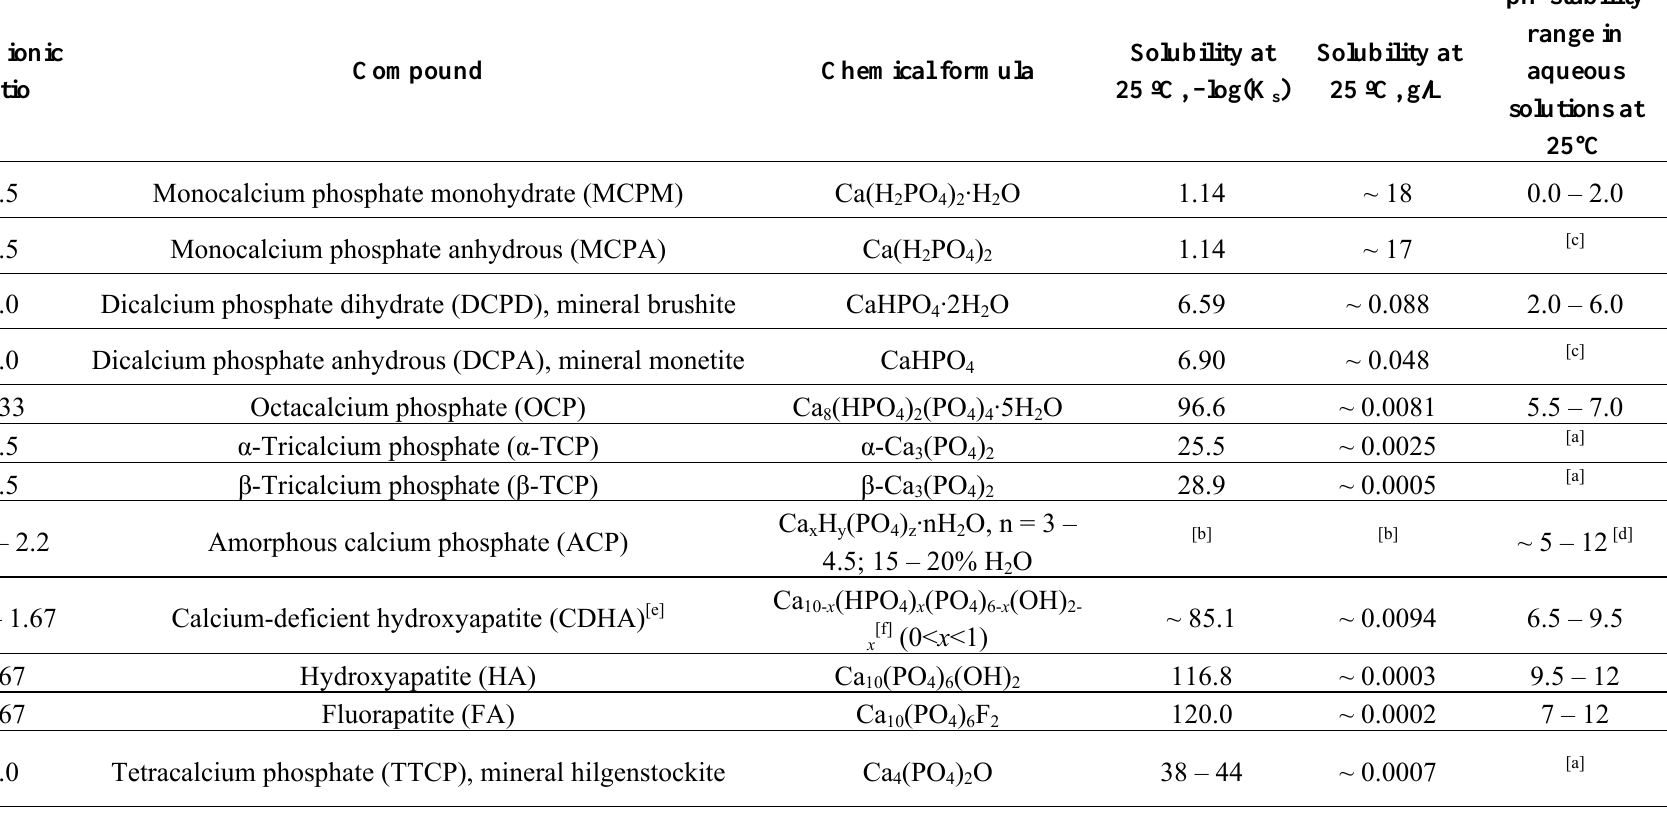
Table 2. Existing calcium orthophosphates and their major properties